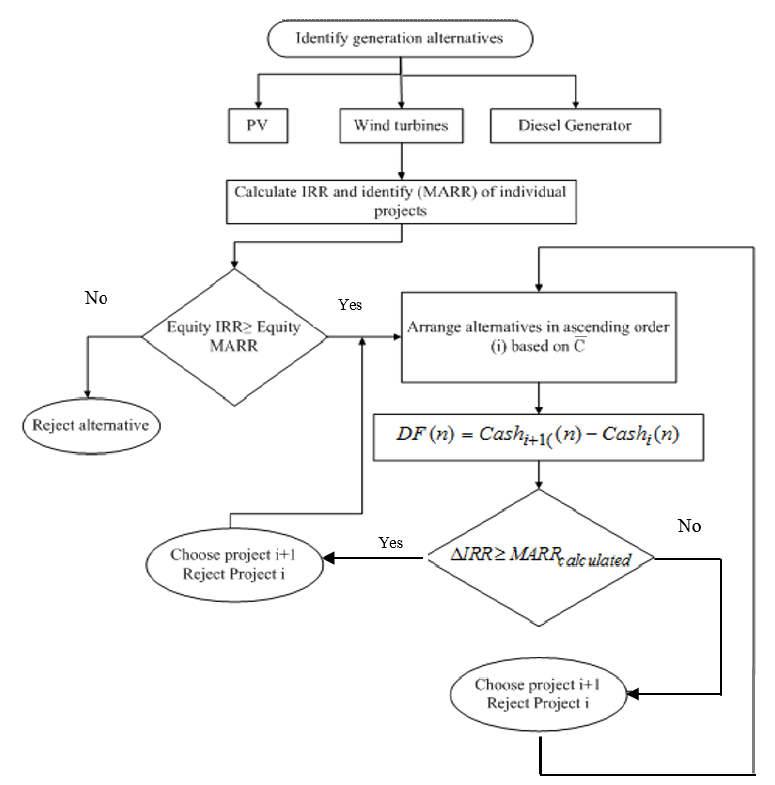
Figure 6. Incremental IRR analysis execution.